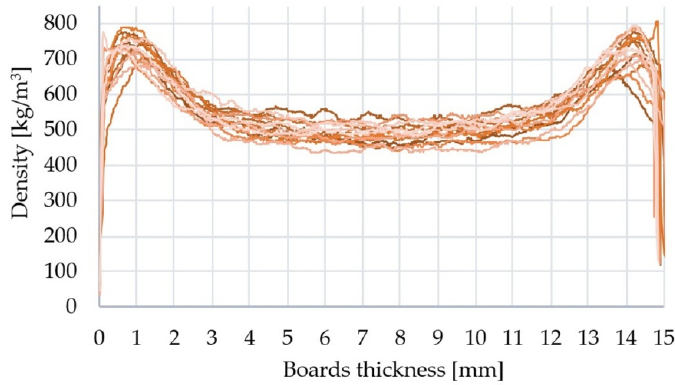
Figure 2. Density profiles of particleboards produced.